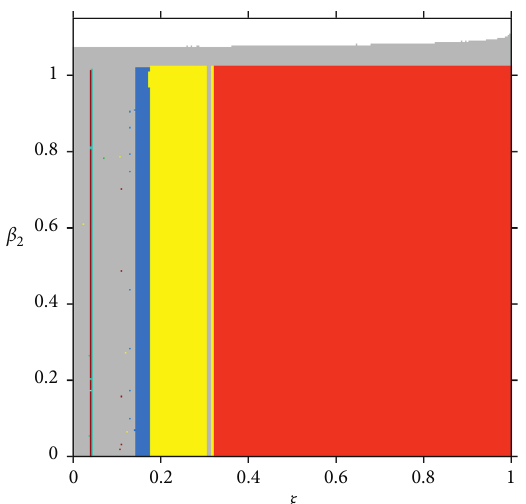
Figure 36: 2D bifurcation diagram with respect to β